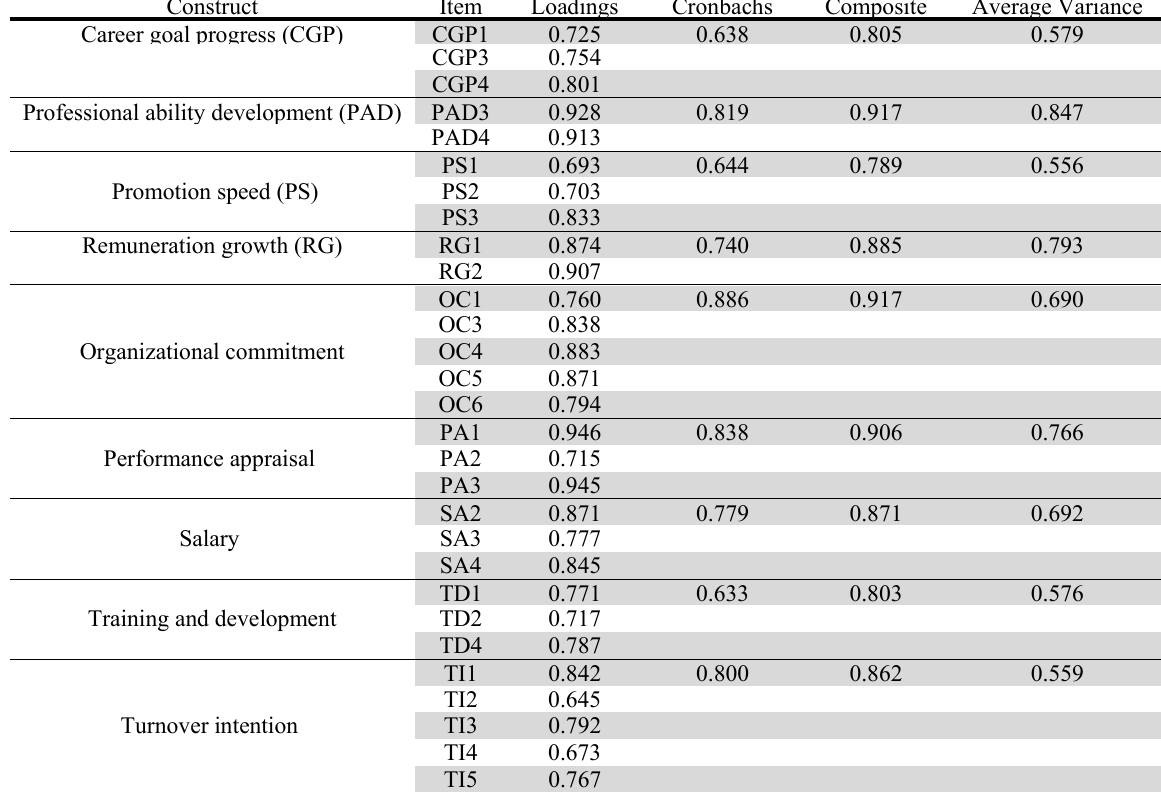
Results of Measurement Model